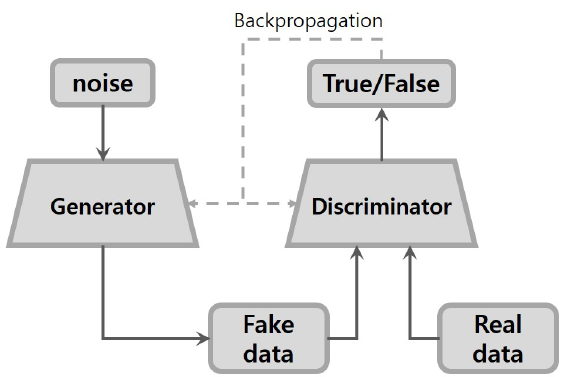
Figure 1. Architecture of basic generative adversarial networks (GANs).